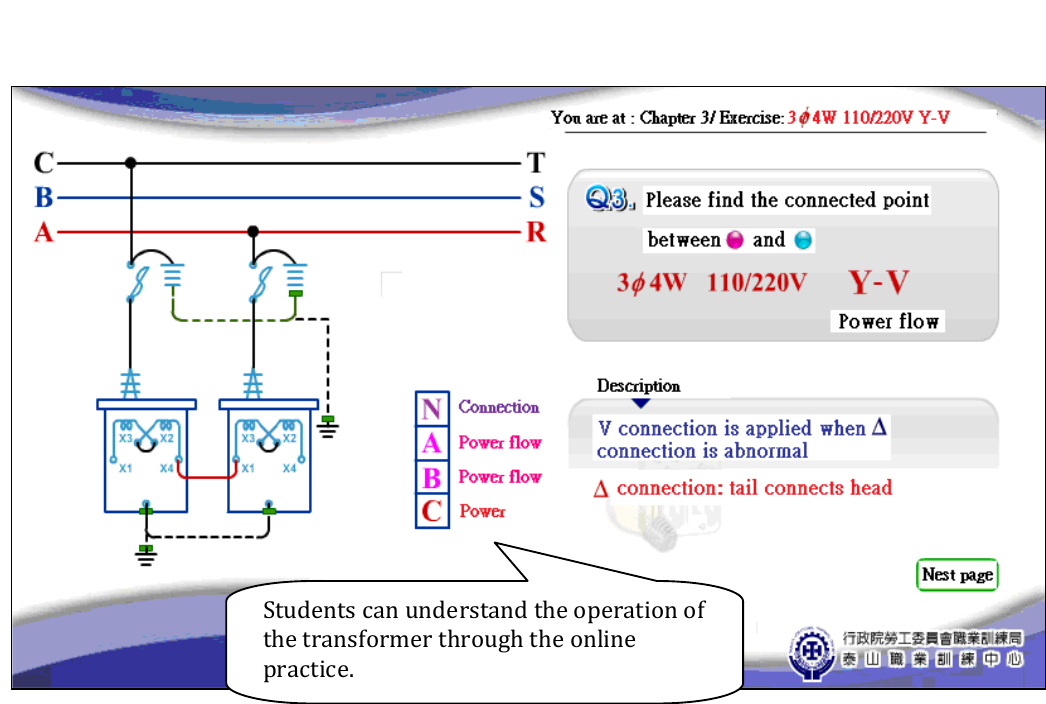
Students can understand the operation of the transformer through the online Figure 1 . The Employment e-Training Platform Website.